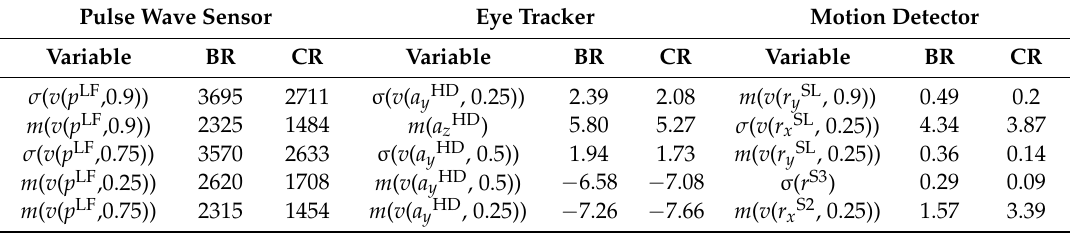
Table 10. Top five of the important variables for predicting the engagement in the personalized model. Pulse Wave Sensor Eye